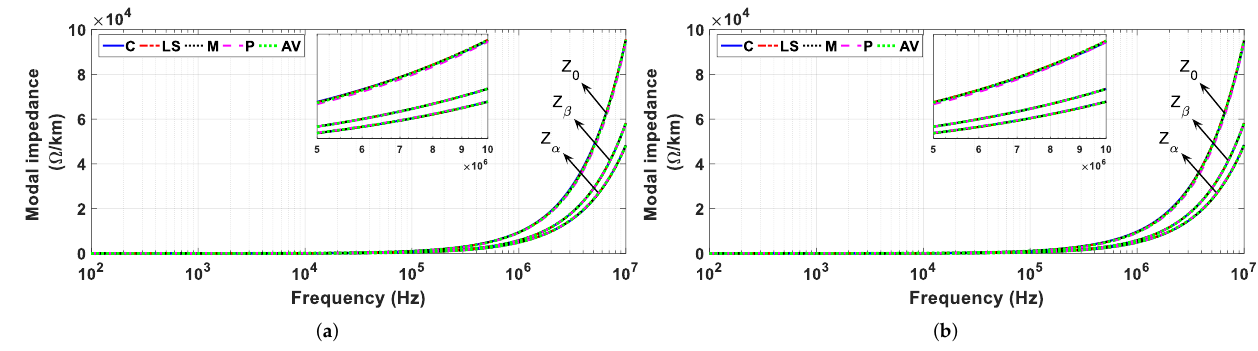
Figure 9. Magnitude of the modal impedance for a soil of: ( a ) 700 Ω · m and ( b ) 4000 Ω · m.